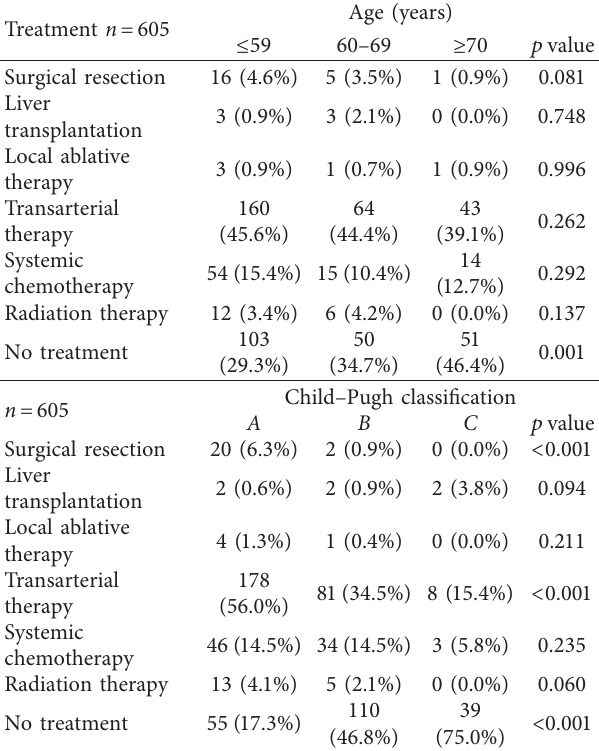
Table 3: Treatment pattern change by age and the Child–Pugh classification in PVT-positive patients. Treatment n � 605